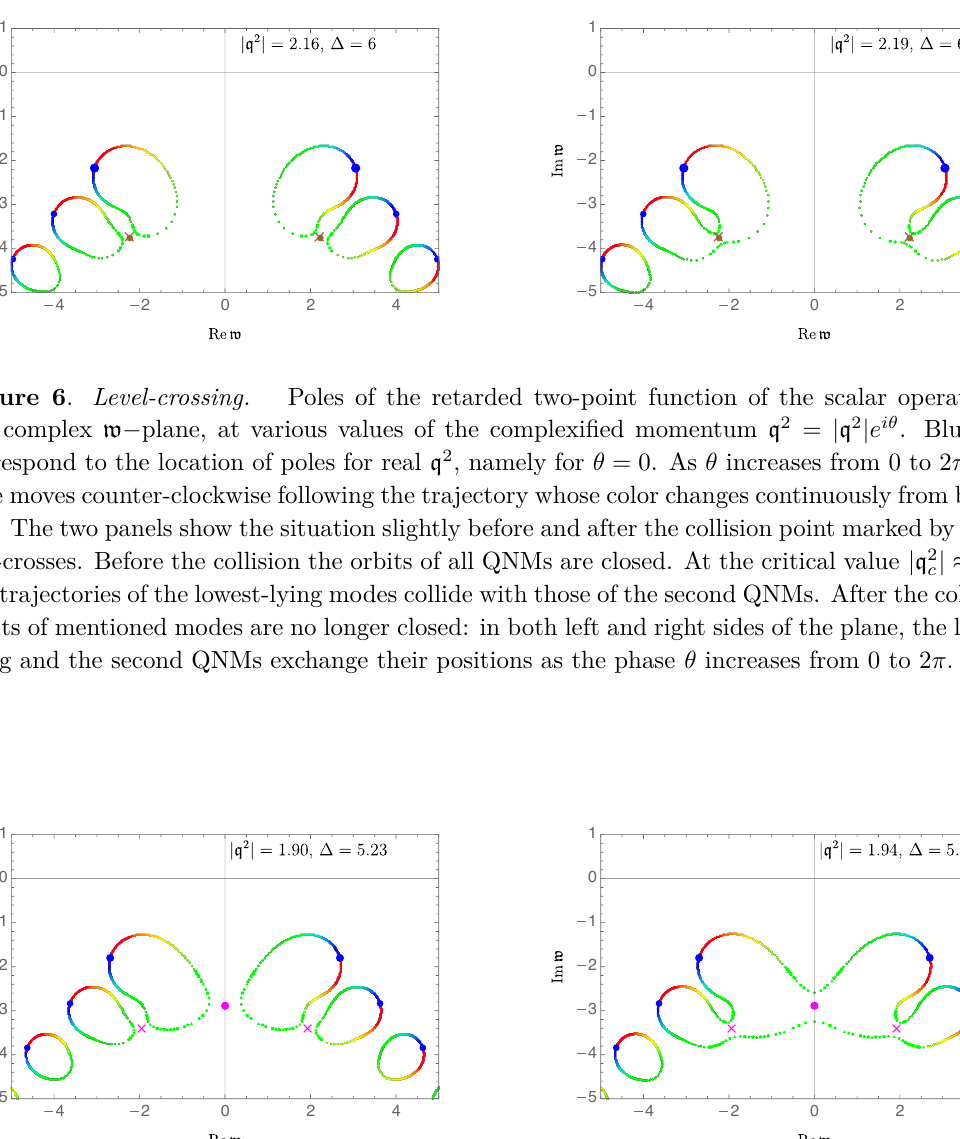
Figure 7 . Simultaneous level-crossing and lowest-level-degeneracy at transition. This figure shows the same modes as figures 5 and 6 but now at the intermediate value of the conformal operator dimension ∆ = 5 . 23 . That is approximately the transition dimension ∆ t which separates the two types of collision regimes, level-crossing versus lowest-level-degeneracy, from each other. It is apparent that now both types of collisions appear simultaneously. Before the collision, in the left panel, the two lowest-lying QNMs ( n = 1 ) have two separate trajectories, and the two second QNMs ( n = 2 ) have two separate trajectories. These four trajectories then collide with each other simultaneously at the three critical points indicated by the magenta dot and the magenta crosses. These collision points are also displayed in magenta in the complex momentum plane in figure